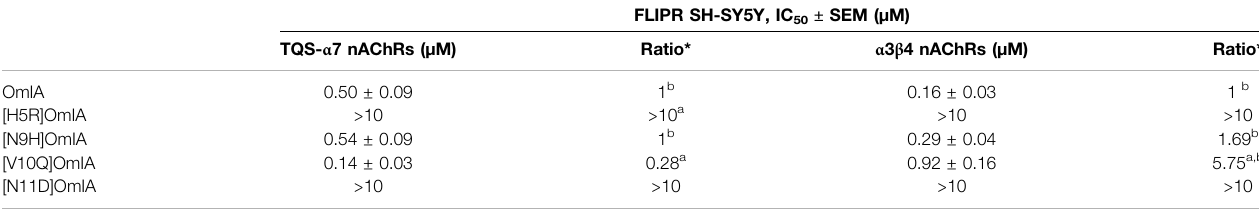
TABLE 3 | IC 50 values for the inhibition of choline activation of α 7 nAChRs with the addition of nAChR type II PAM TQS and α 3 β 4 nAChRs in SH-SY5Y cells by OmIA and its analogues. *Ratios were calculated between OmIA and its analogues. Data represent mean ± SEM of triplicate data from three independent experiments. a denotes signi fi cant difference in IC 50 values to wildtype OmIA ( p < 0.05). b denotes 95% CIs for curve bottom values non-overlapping 0%.